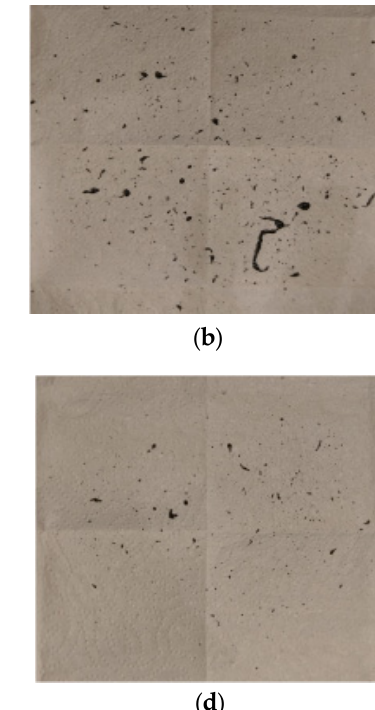
variant 3; ( c ) variant 2; ( d ) variant 4.